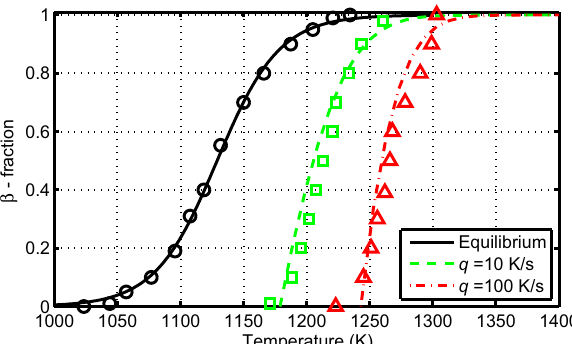
Figure 6. Volume fraction of β phase as a function of temperature calculated (lines) by using model A versus measured data (markers) 11 for Zr1NbO at heating rates q equilibrium.